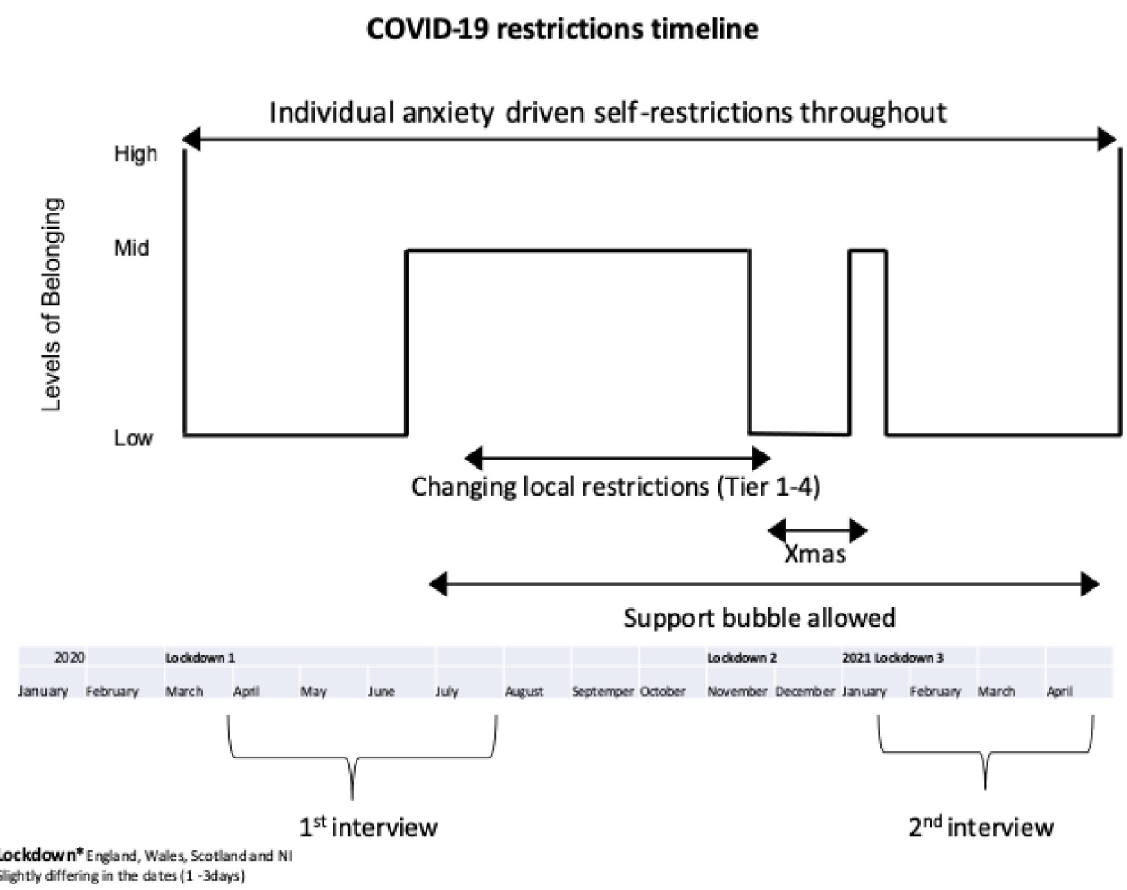
Fig 1. Enacted sense of belonging: Timeline (April 2020-April